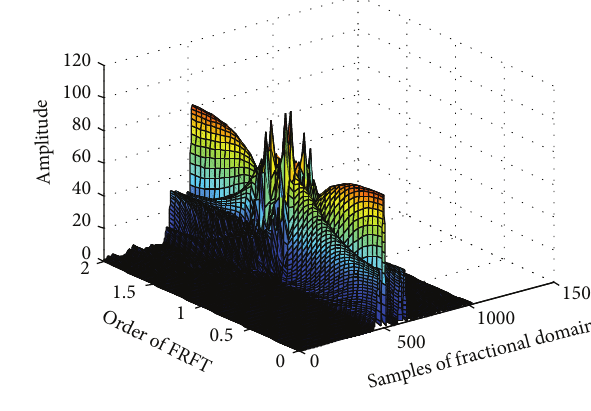
Figure 8: DWT-FRFT of